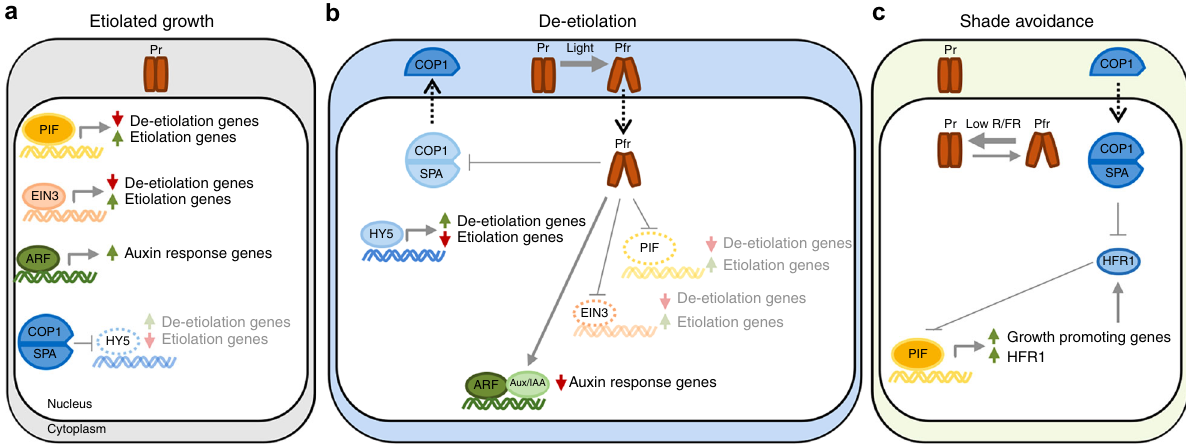
Fig. 3 Simpli fi ed mechanism for phytochrome control of transcription factors in different light environments. a Below the soil surface during etiolated growth. For simplicity we consider that phytochromes remain inactive (Pr) below the soil surface, which results in accumulation of transcription factors PIFs, EIN3, and ARFs and subsequent induction of etiolation and auxin response genes. The COP1/SPA ubiquitin E3 ligase accumulates in dark and leads to proteasome-mediated degradation of HY5, a transcription factor that suppresses the expression of genes required for etiolation and induces expression of genes required for de-etiolation. b During de-etiolation upon light perception. Light perception activates phytochromes (Pfr) which promote de-etiolation by directly inhibiting PIFs and EIN3, and indirectly inhibiting ARFs by stabilizing Aux/IAA proteins. The Pfr form of either phyA or phyB interacts with SPA proteins, resulting in inhibition of COP1/SPA. This results in stabilization of HY5 leading to induction of de-etiolation related gene expression and repression of etiolation genes. c In a deetiolated plant in response to shade (reduced R/FR). Low R/FR in shade reduces the fraction of active phytochrome (Pfr/Ptot). PIFs accumulate and induce growth-promoting gene expression. In addition, PIFs induce a negative feedback loop exempli fi ed by HFR1 expression. HFR1 (and other HLH proteins) binds to PIFs forming non-DNA-binding heterodimers. COP1/SPA is also involved in this loop by leading HFR1 to proteasome-mediated degradation. Arrows indicate positive regulation, blunt-ended arrows indicate negative regulation, and dotted-lined arrows indicate nucleo-cytoplasmatic